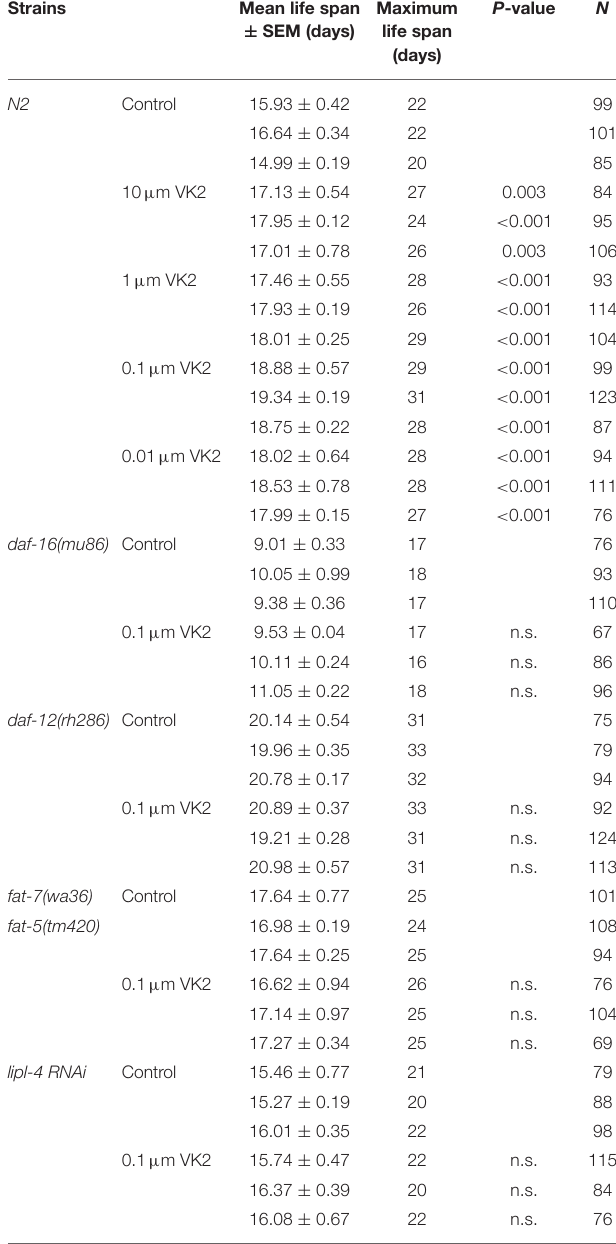
Mean lifespans were calculated by using Kaplan-Meier method; P-values compared with Controls were determined using the log-rank test; n.s., no significant difference; SEM, standard error of the mean; N, number of worms